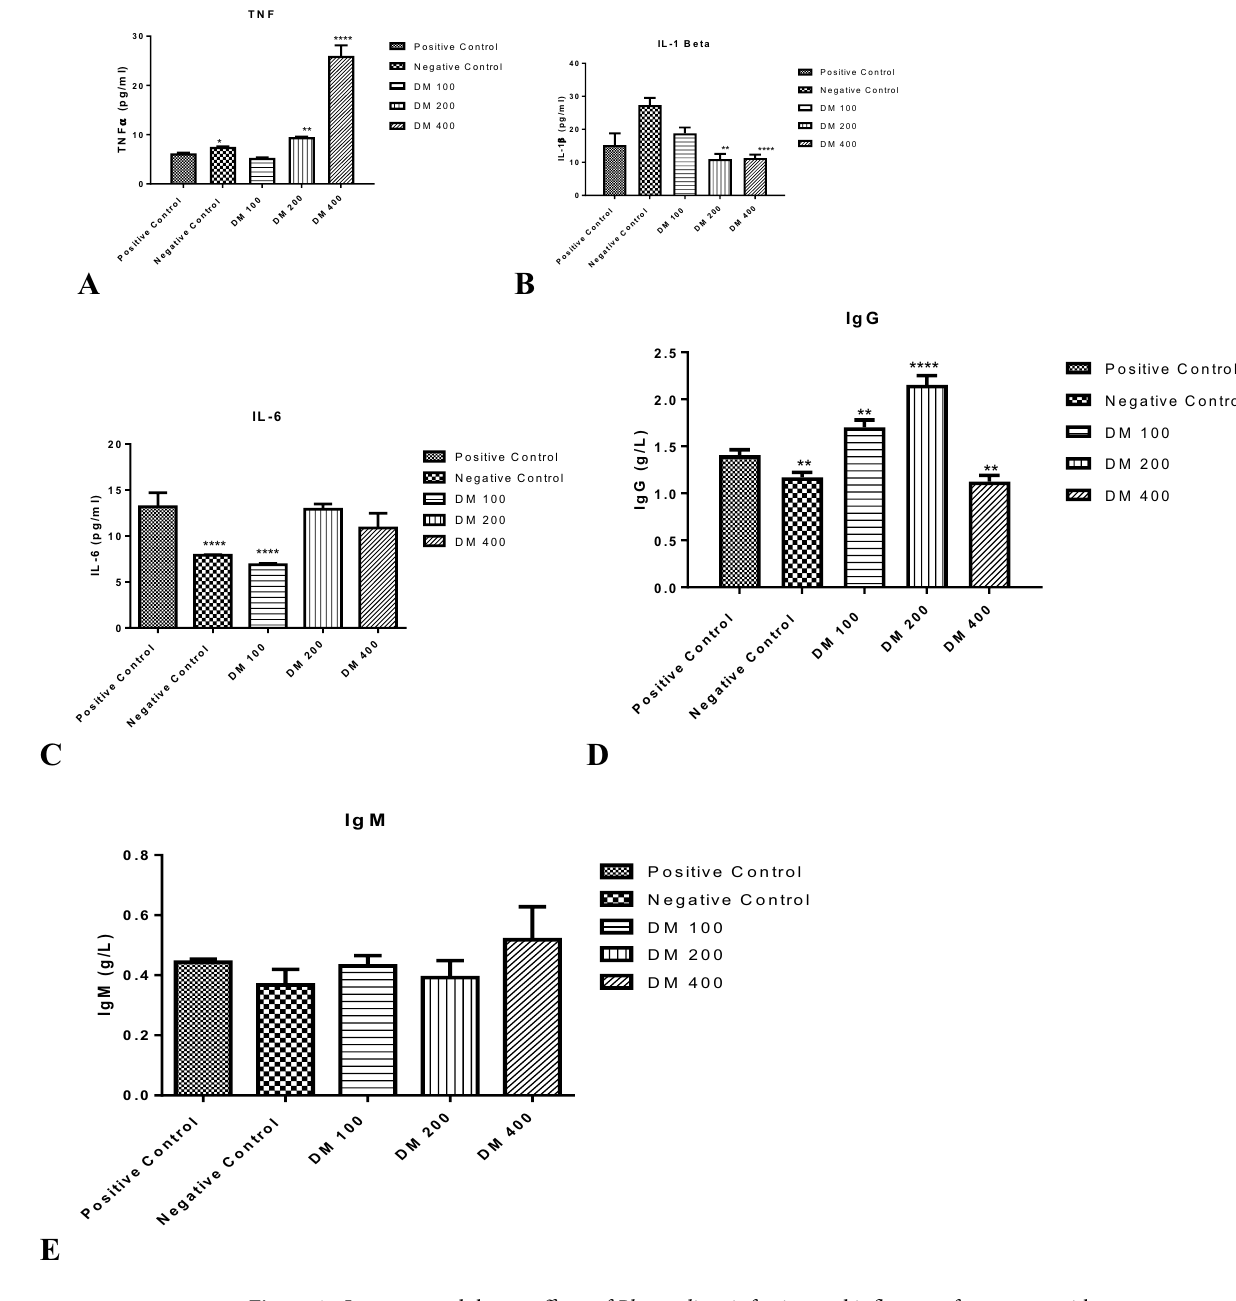
Figure 4. Immunomodulatory effects of Plasmodium infection and influence of treatment with dichloromethane fraction of Diospyros mespiliformis . ( A ) Serum TNFα significantly increased ( P < 0.0001) maximally at 400 mg/kg of dichloromethane fraction of D. mespiliformis administration. ( B ) Serum interlukin (IL-1β) significantly ( P < 0.0001) decreased in the DF-treated groups relative to the drug control while serum interlukin 6 (IL-6) of infected control and 100 mg/kg DF significantly ( P < 0.0001) decreased relative to positive control ( C ). ( D ) IgG value increased maximally at 200 mg/kg of DF and ( E ) there is no significant difference in the IgM value in all the